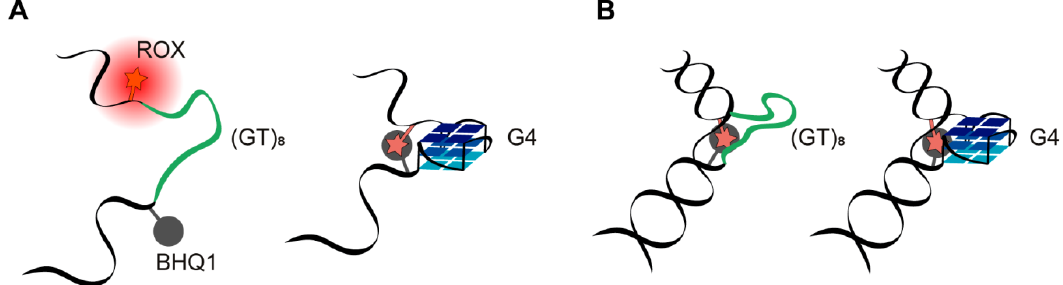
Figure 7. The mutual arrangement of the ROX fluorophore (red asterisk) and dark quencher BHQ1 (gray circle) attached in the immediate proximity to the ends of G4 or disordered d(GT) 8 inserts within single- and double-stranded DNAs. ( A ) Oligonucleotides 41G4-ROX-BHQ1 and 41(GT) 8 -ROX-BHQ1. ( B ) Duplexes 41G4-ROX-BHQ1/22 and 41(GT) 8 -ROX-BHQ1/22.